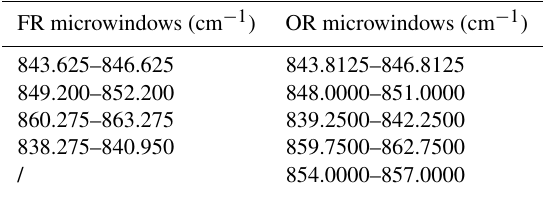
Table 1. Microwindows used for the COCl 2 retrievals of FR (left column) and OR (right column)